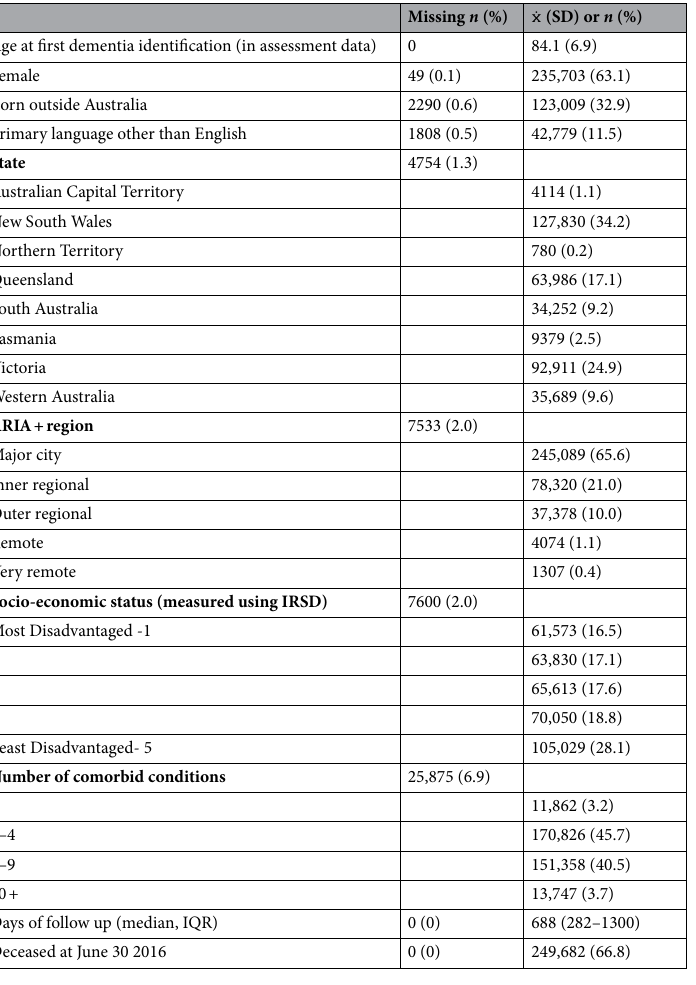
Table 1. Overall study cohort demographic characteristics and co-morbidity burden ( n = 373,695). ARIA Accessibility/Remoteness Index of Australia, IQR Interquartile range, IRSD Index of Relative Socio-economic disadvantage, SD Standard